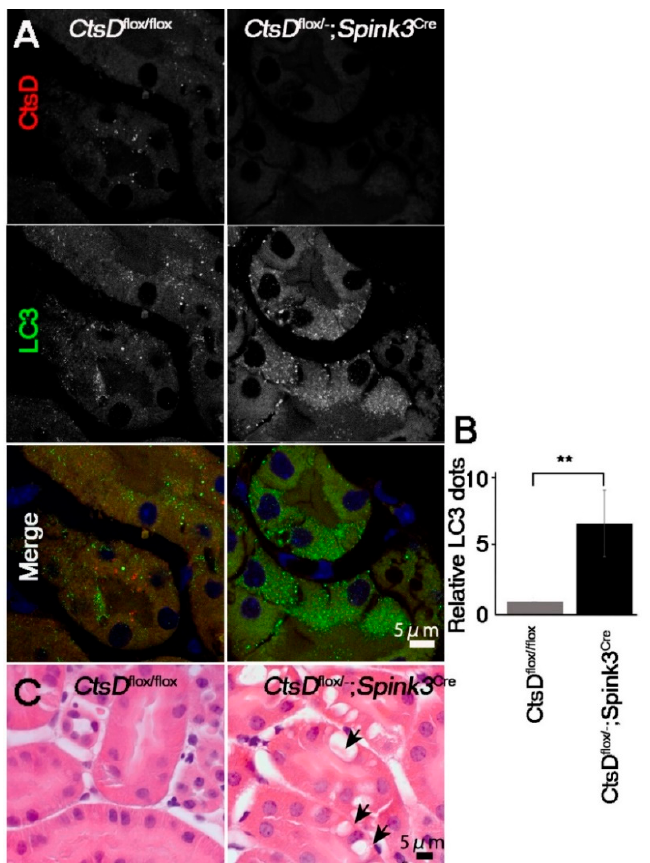
Figure 2. CtsD -deficiency resulted in an increase of LC3-positive signals and vacuoles in renal proximal tubular epithelial cells. ( A ) Representative confocal microscopic images of cathepsin D (CtsD) and LC3 immunostaining in CtsD flox/flox and CtsD flox/ − ; Spink3 Cre mouse kidneys. In the CtsD flox/ − ; Spink3 Cre mice, LC3 signals increased and formed granules in the cathepsin D depleted cells. Bar, 5 µ m. ( B ) The number of LC3 positive dots are counted in the CtsD positive proximal tubular cells in CtsD flox/flox and CtsD negative proximal tubular cells in CtsD flox/ − ; Spink3 Cre mouse. n = 3 in each group. Values are given as the mean ± SEM. ** p < 0.03 ( C ) Hematoxylin and eosin staining of the cortico-medullary region in CtsD flox/flox and CtsD flox/ − ; Spink3 Cre mouse kidneys. Black arrows in CtsD flox/ − ; Spink3 Cre indicate large vacuolar structures. Bar, 5 μ m.